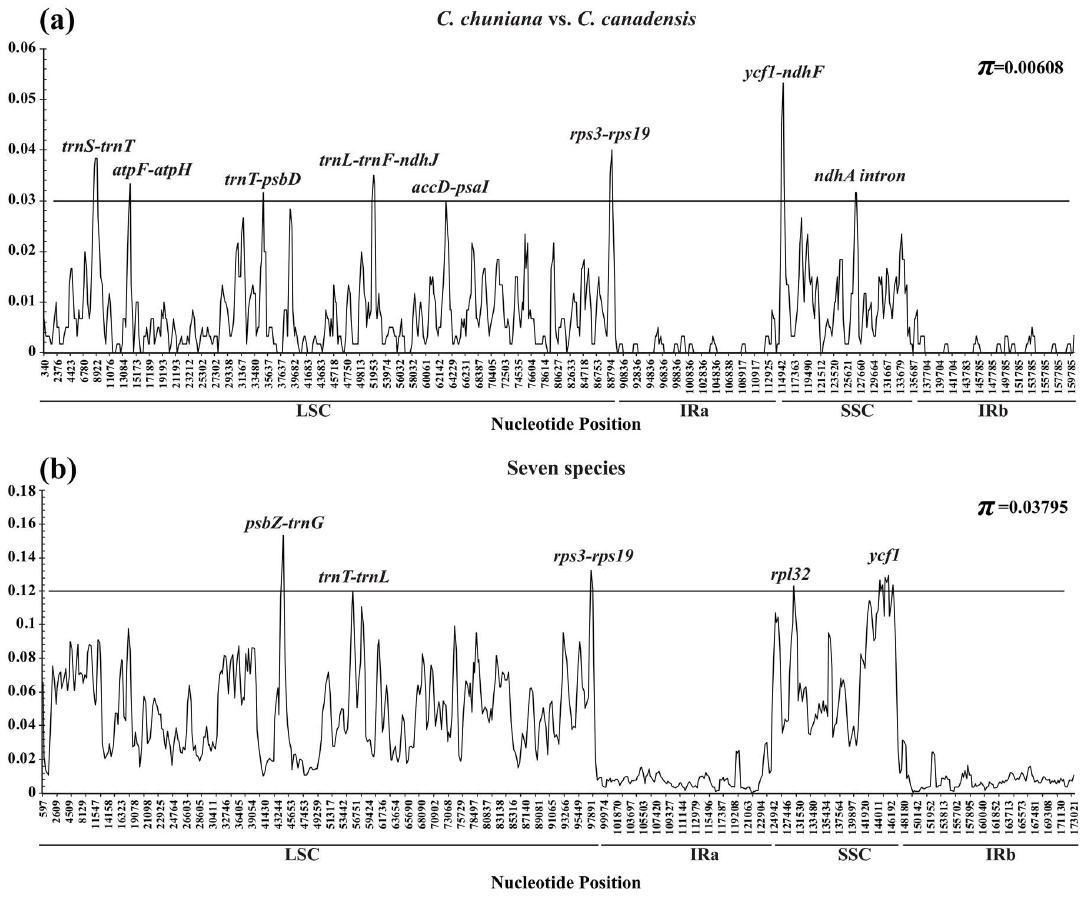
Figure 4. Sliding window analysis of the whole cp genome. ( a ) C. chuniana and C. canadensis ; ( b ) All seven species. X -axis: position of the midpoint of a window; Y -axis: nucleotide diversity ( π ) of each window.